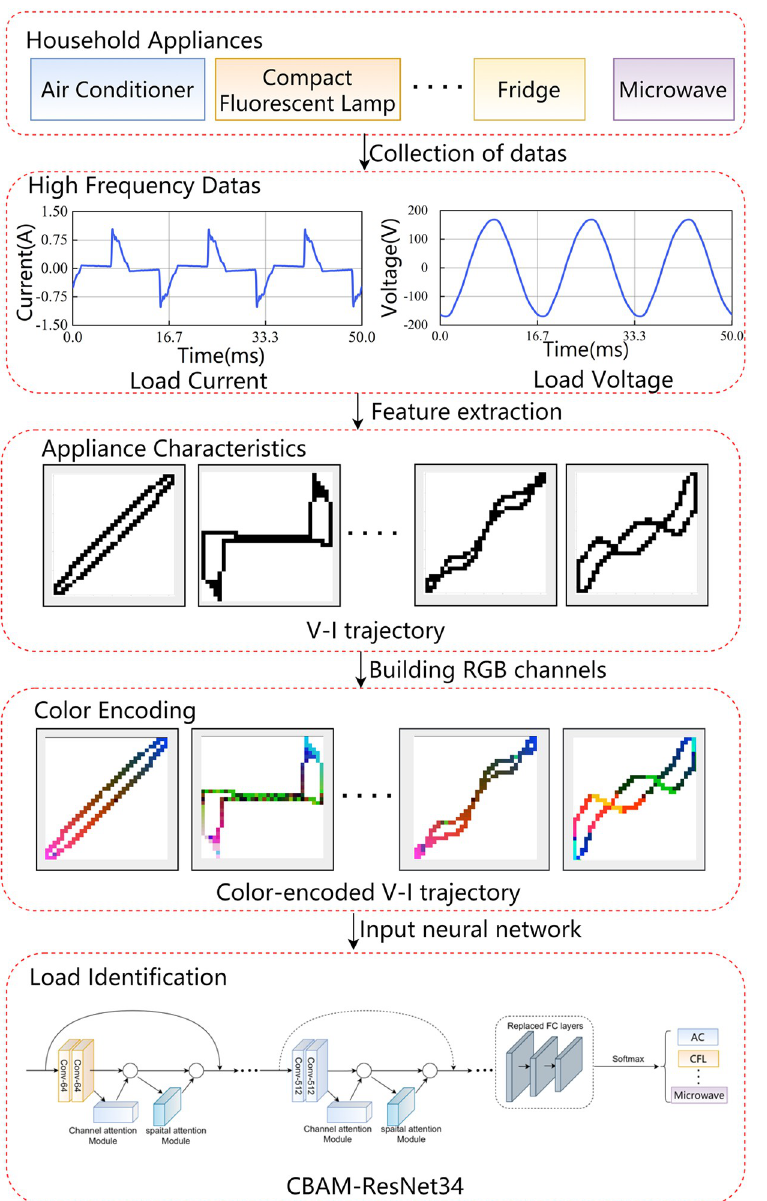
Fig 1. The process structure of power fingerprint